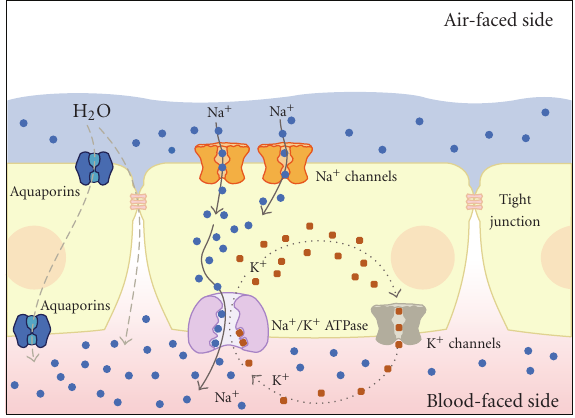
Figure 1: Transepithelial Na + transport drives alveolar fluid clearance. Na + enters the cell interior passively following an electrochemical gradient via Na + channels, which are located at the apical membrane of alveolar epithelial cells. The Na + ions are then actively pumped out of the cells by the Na + /K + -ATPase in exchange for K + ions, which leave the cell afterwards via basolaterally localized potassium channels. Thus, there is a net movement of Na + ions from the apical (air-faced) to the basolateral (blood/interstitium- faced) side of the alveolar epithelium. This creates osmotic forces, and, consequently, water follows out of the airspaces across the epithelium either paracellularly via tight junctions or transcellularly via aquaporins. The figure has been modified from